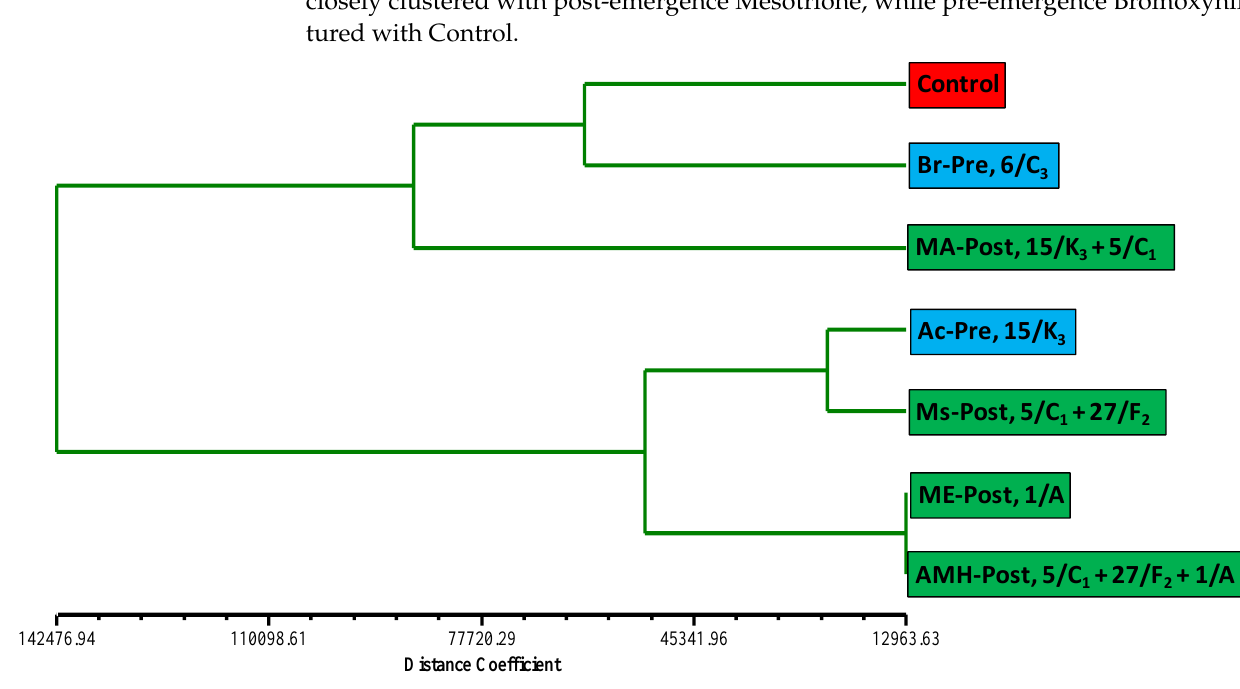
Figure 9. Unweighted pair group method with arithmetic mean cluster analysis using the sequen- tial agglomerative hierarchical non-overlapping method of different herbicides based on collective morpho-anatomical attributes. Mode of action: The numeric are classified by Weed Science Society of America, K3-Inhibition of cell cycle, C3 and C1-Inhibition of photosynthesis in photosystem II, A-Inhibition of Acetyl-CoA Carboxylase (ACCase), F2-Inhibition of carotenoid biosynthesis in 4-hydroxyphenyl-pyruvate-dioxygenase (4HPPD). Red color indicates control group, blue show pre-emergence and green is used for post-emergence herbicides. For abbreviations please see list at the end of